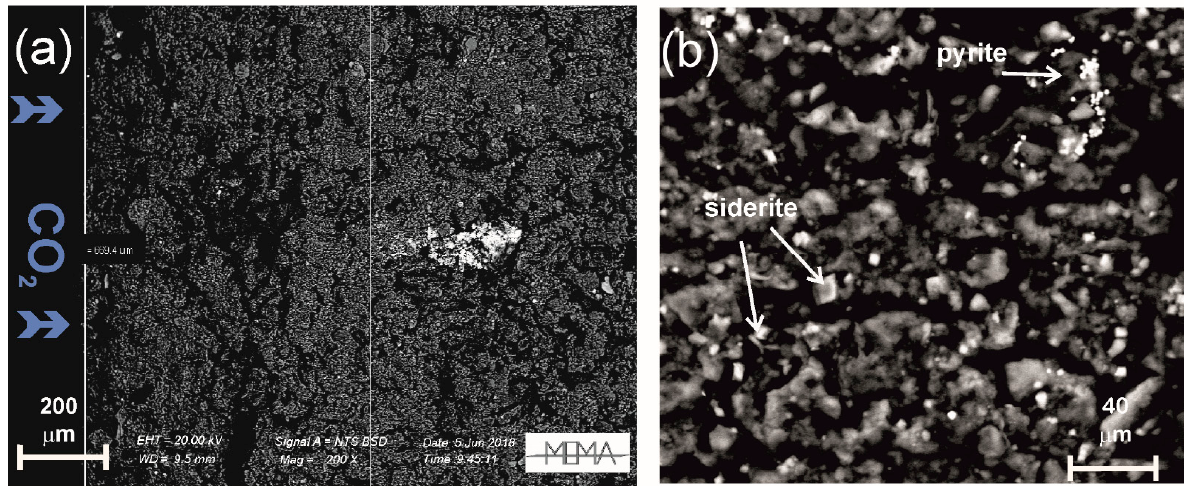
Figure 9. SEM images of sample C1 after 2 days of experiments, oriented with respect to the CO 2 entry. ( a ) Low magnification view. The two white lines represent, from left to the right, the sample outer edge with CO 2 richer fluids, the pyrite and other Fe-rich mineral dissolution and the secondary minerals reaction front and, on the right the zone of deposition. ( b ) Zoom on the matrix with the formation of Fe-richer carbonate (siderite) as a secondary mineral. Images taken from a piece on a stub. Table 6. Diffusion coefficients obtained from experiments.